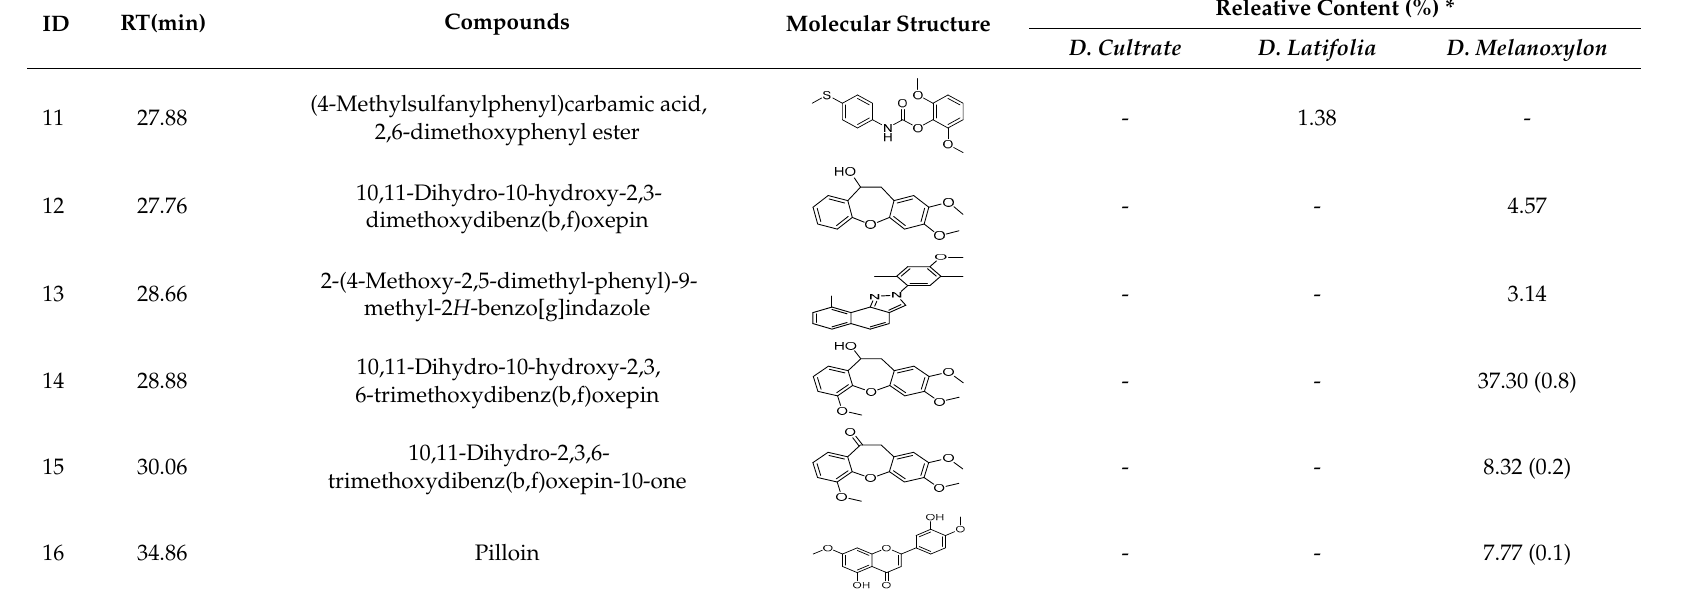
* The percentage was calculated based on the peak area. Values in the parentheses are the deviations of three replicates. Deviations lower than 0.1% are not listed in the table.